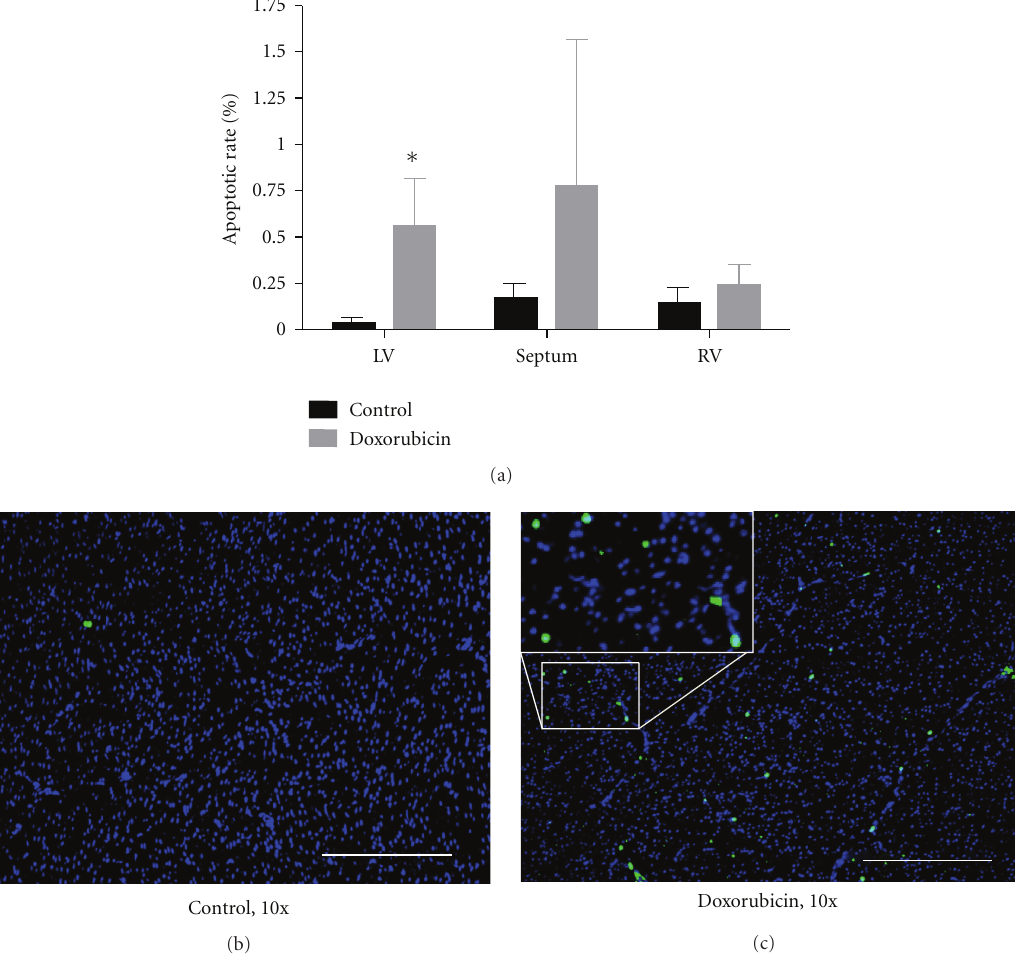
Figure 6: (a) Myocardial apoptotic rate determined with TUNEL staining in control and doxorubicin-treated hearts. (b) and (c) Representative TUNEL staining (with DAPI costaining) in control and doxorubicin-treated hearts. Nuclei are stained blue. TUNEL positive nuclei are green/cyan. 10x, white bar = 200 μ m, ∗ P < 0 . 05 versus control. LV, left ventricle; RV, right ventricle; n =